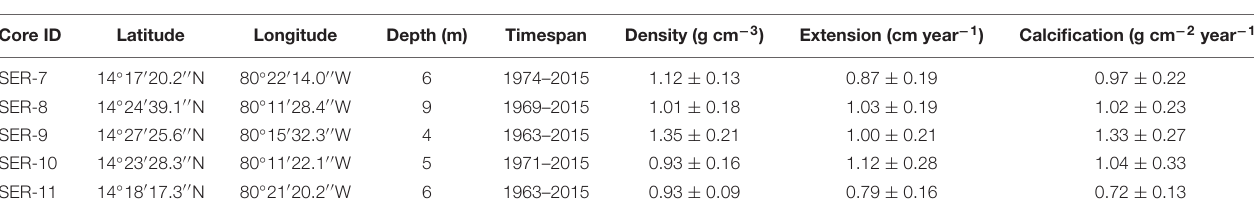
FIGURE 1 | Location of the Serrana Atoll in the Colombian Caribbean (dashed line). Sampling sites are indicated by white dots with the corresponding core code shown. Satellite image obtained and edited from the Landsat 8 OLI/TIRS C1 L-1 dataset (https://earthexplorer.usgs.gov/), taken on March 4, 2018. TABLE 1 | Location and details of O. faveolata colonies used in this